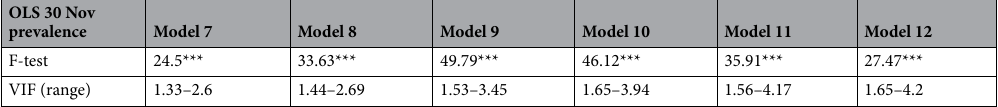
Table 9. Results from OLS models on COVID-19 prevalence rate registered on 30 November 2020. p-value < 0.01***; p-value < 0.05**; p-value < 0.1*. Standard errors in parentheses. All models included a constant, a dummy for regional capitals, and controls for the size of the province, smokers, and obese